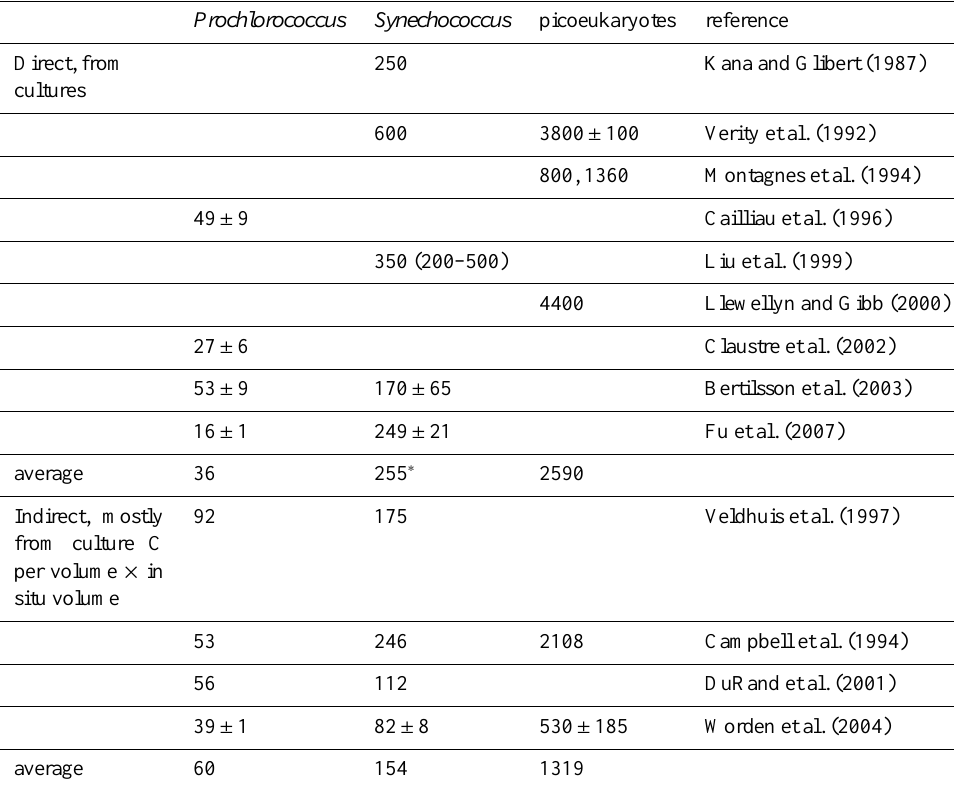
Table 2. Cell abundance to carbon biomass conversion factors [fgCcell − 1